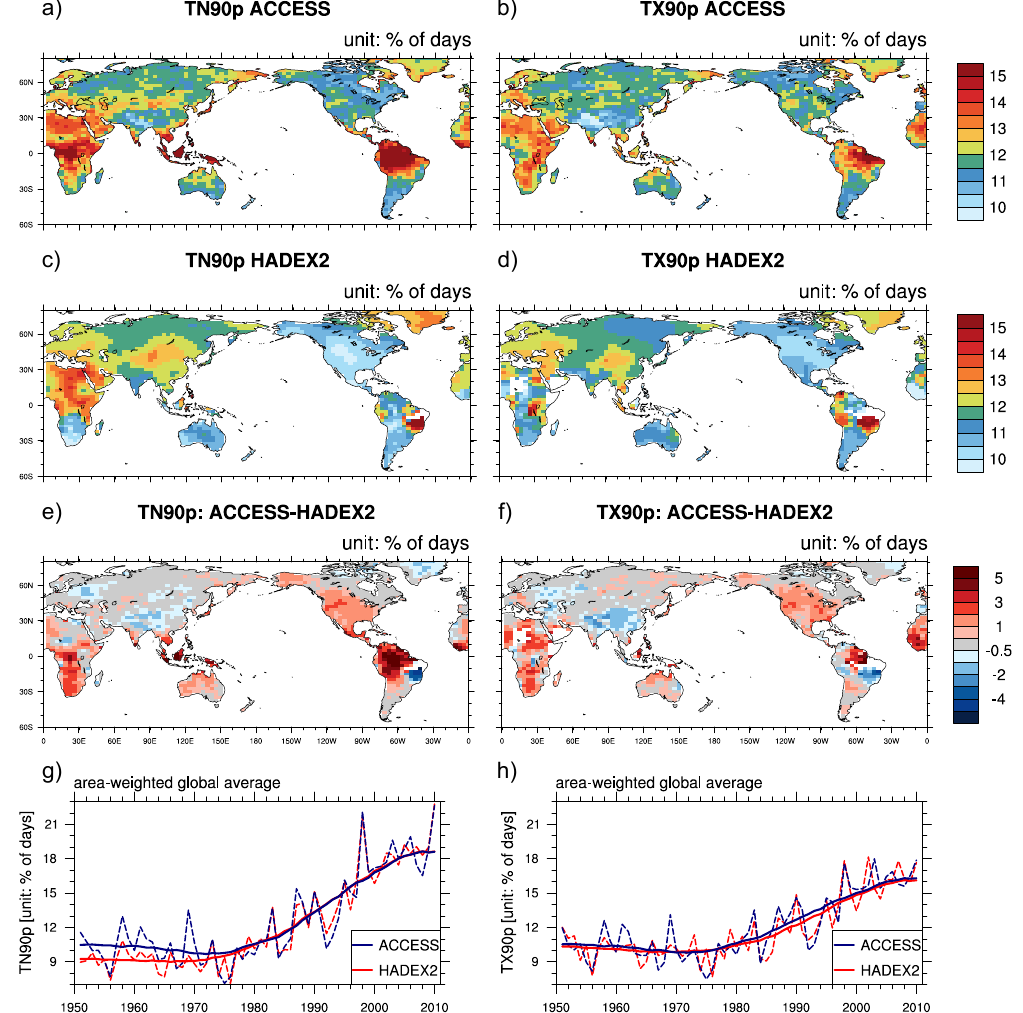
Fig. 5. Annual warm nights (TN90p, left column) and warm days (TX90p, right column) for ACCESS1.3b (a, b) , HadEX2 (c, d) , bias (e, f) and the global average time series showing trends (g, h) . Unshaded areas reflect missing observation data. We applied a static masked only including grid points where more than 50 years of data (out of 60) were available to calculate the global average. The solid lines in (g) and (h) show the time series smoothed by a 21-year Gaussian filer, while the dashed lines show the yearly